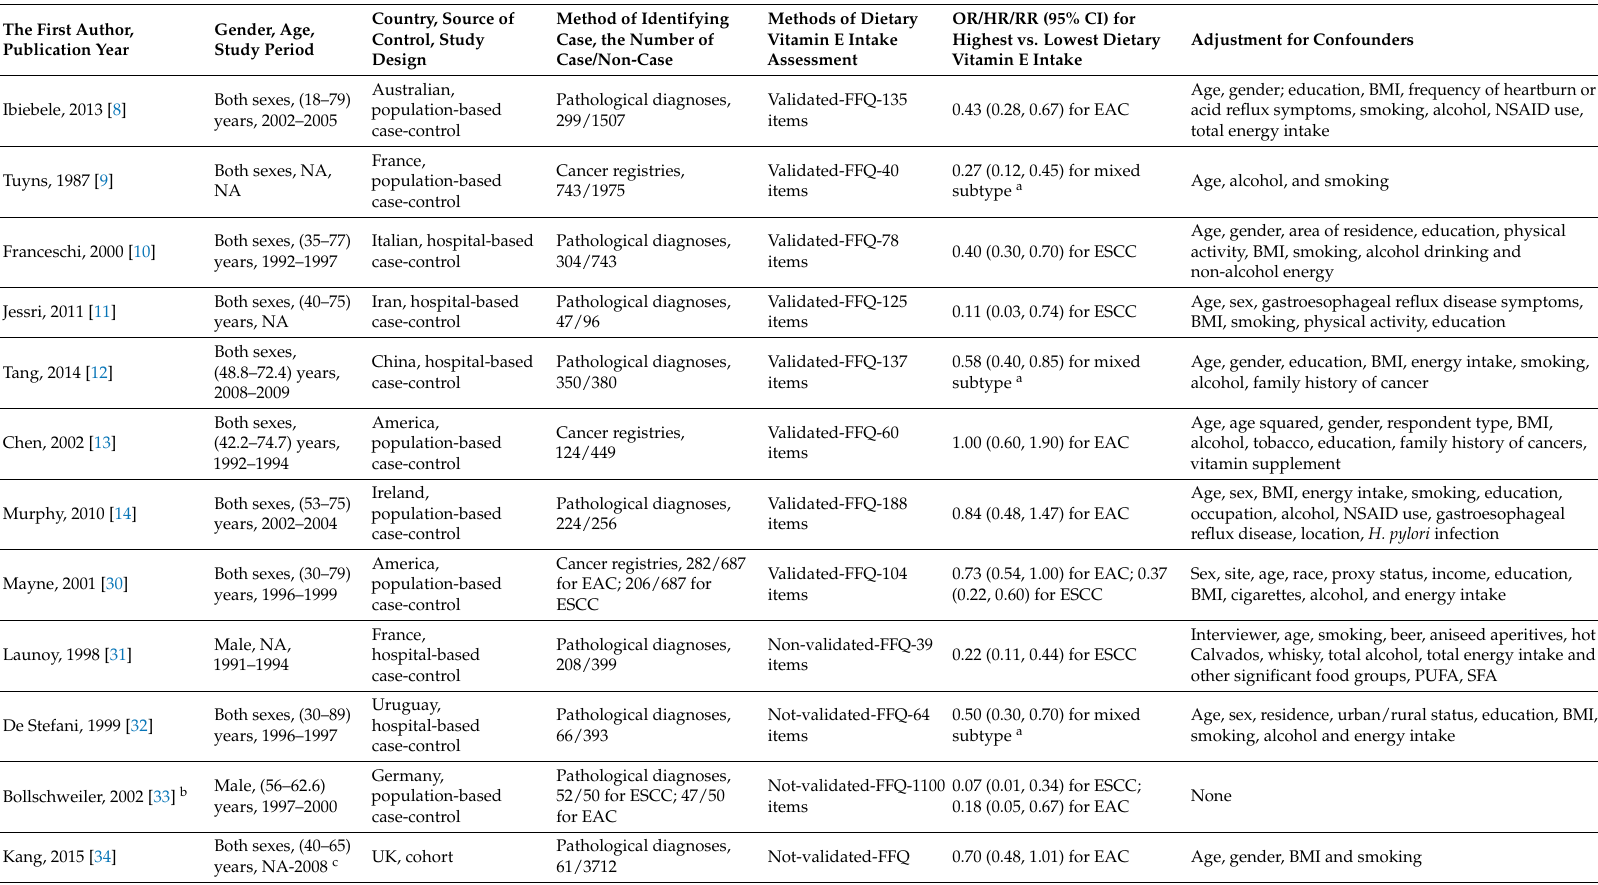
Table 1. Characteristics of included studies on the association between dietary vitamin E intake and esophageal